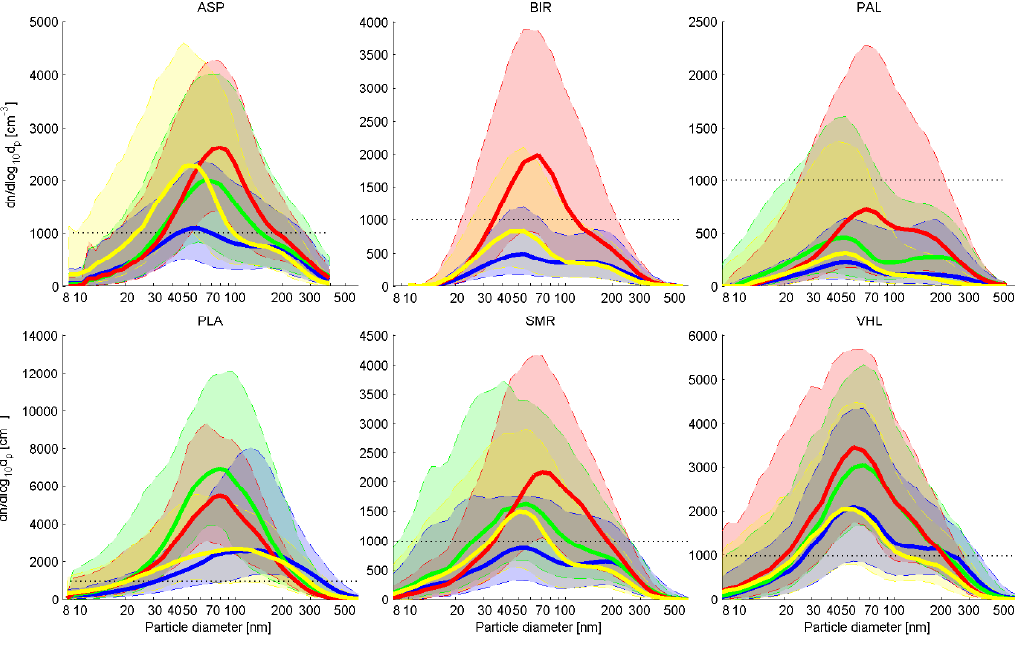
Fig. 4. Median distributions (solid line) and 16th and 84th percentile distributions (shaded areas) divided by seasons at Nordic and Baltic (PLA) stations. The black dotted line shows the 1000 particles cm − 3 dn / d log 10 d p to help the eye on the concentration levels. Blue line and shading denote winter, green line and shading spring, red line and shading summer and yellow line and shading autumn months datasets.